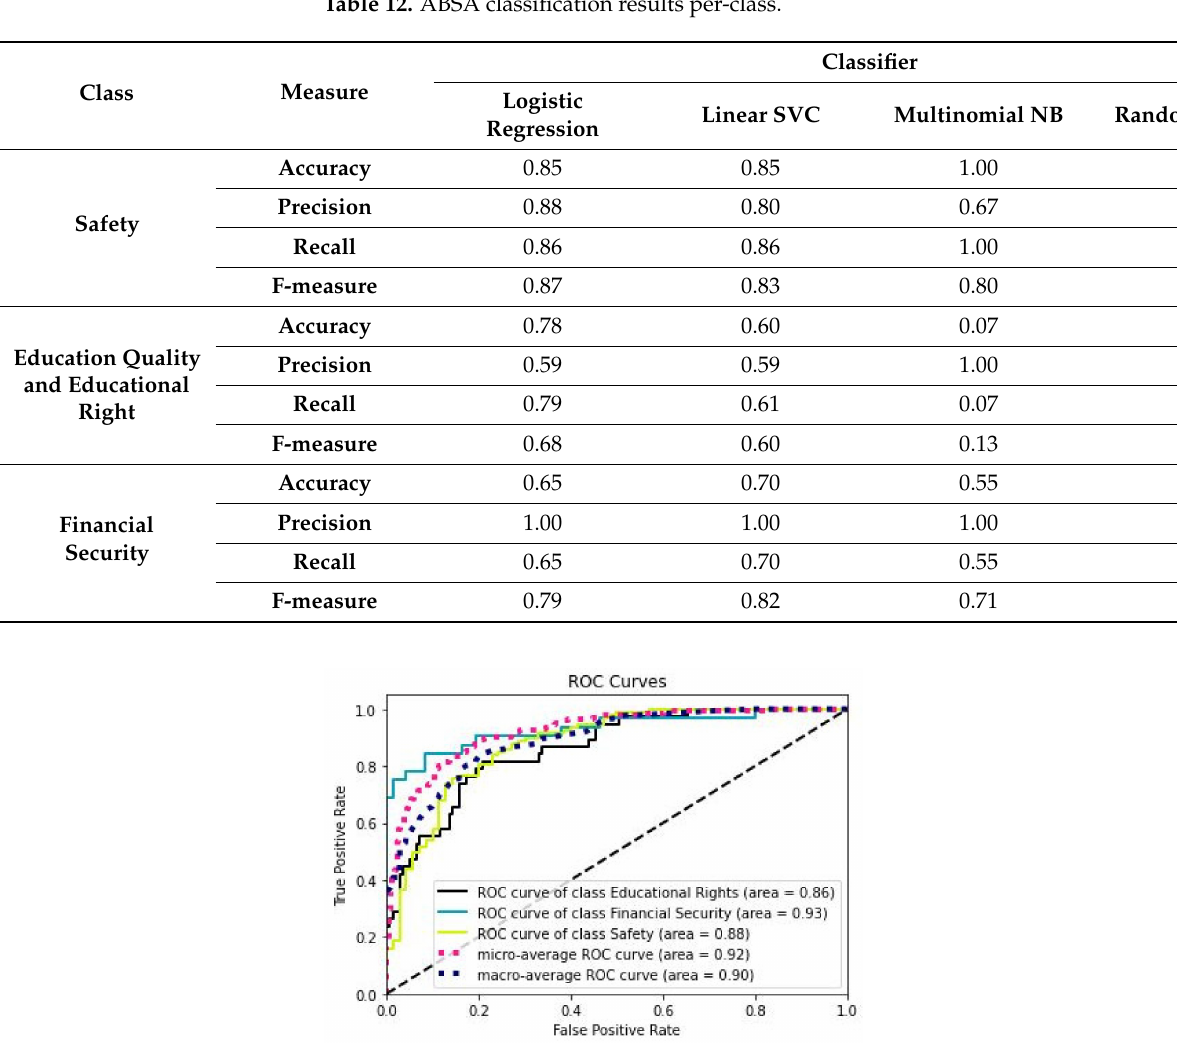
Figure 7. Logistic regression ROC—Aspect classification.